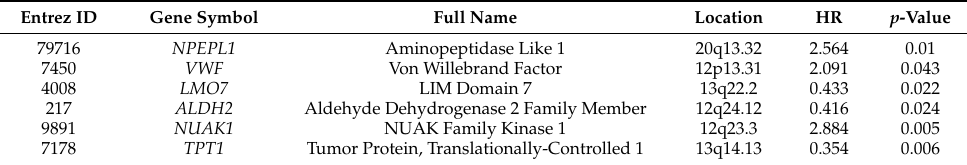
Figure 3. Identification of CRPC-associated genes that correlate with recurrence-free survival (RFS) in PCa. ( a ) Partial likelihood deviance of different numbers of variables revealed by the LASSO regression model. The red dots represent the partial likelihood deviance values. The grey lines represent the partial likelihood deviance ± standard error (SE). The two vertical lines on the left and right represent optimal values by minimum criteria and 1-SE criteria. The proper log (Lambda) value was chosen by 10-fold cross-validation via minimum criteria. LASSO: least absolute shrinkage and selection operator method. ( b ) LASSO coefficient profiles of the 24 CRPC-associated genes. ( c ) The Kaplan–Meier survival curves showing patients with higher expression levels of ALDH2 (left), LMO7 (center), and TPT1 (right) had a favorable prognosis in PCa ( p < 0.05). ( d ) The Kaplan–Meier curves showing higher expression levels of NUAK1 (left), NPEPL1 (center), and VWF (right) indicated poor prognosis in PCa ( p -value < 0.05). Table 2. Identification and chromosomal location of the six CRPCPS genes and their association with recurrence-free survival (RFS) in prostate